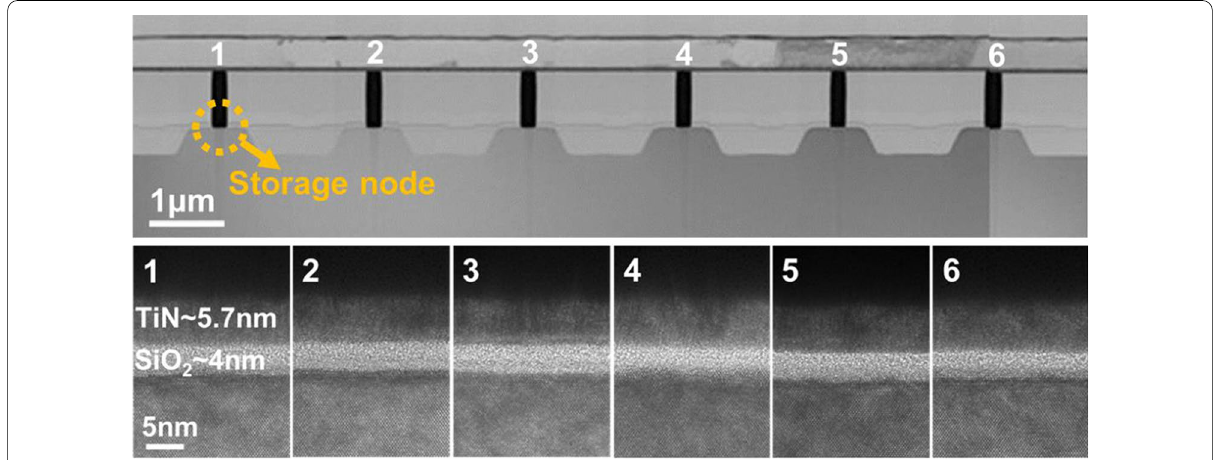
Fig. 1 The layout arrangement of the 16 CRRAM array sample under investigation